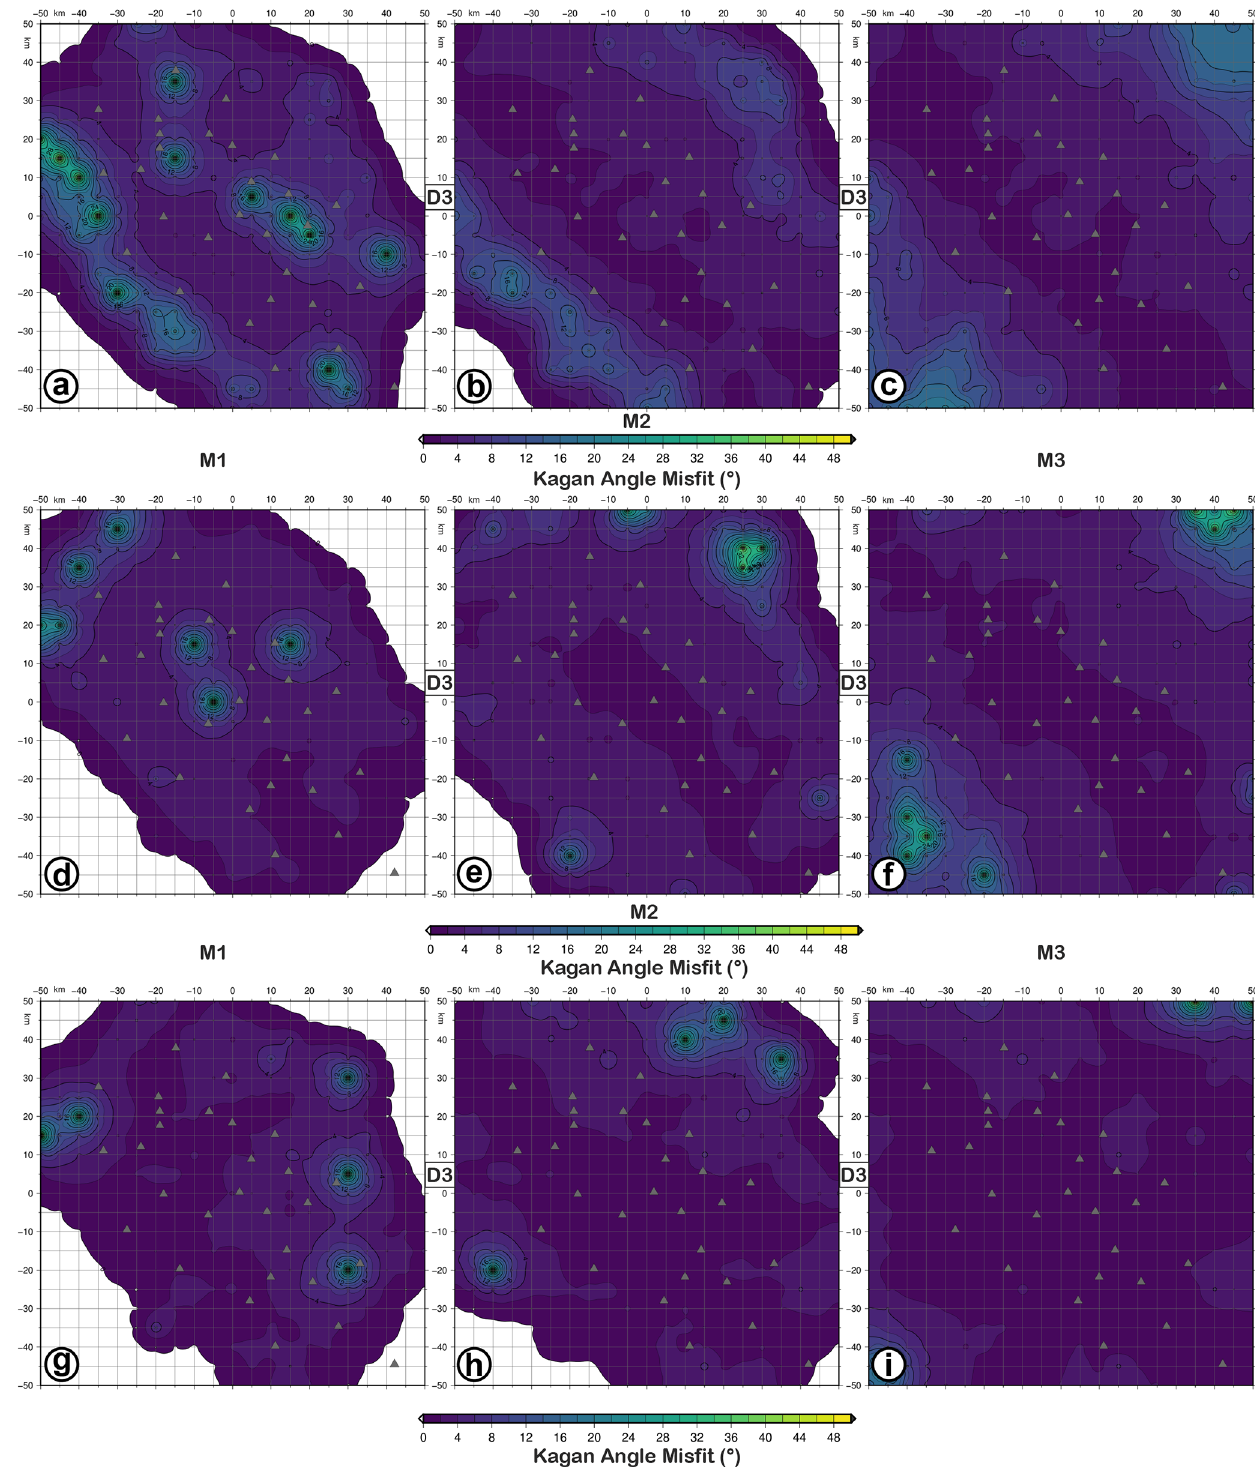
Figure 10. KAM (Kagan angle misfit) maps for retrieved focal mechanisms with D3 datasets as input data and simulating earthquakes with M1 (a, d, g) , M2 (b, e, h) , and M3 (c, f, i) magnitudes and FM1 (a–c) , FM2 (d–f) , and FM3 (g–i) theoretical fault plane solutions at 10km depth. The level of Gaussian noise is set to 5%.